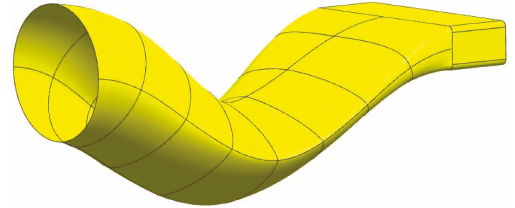
Figure 3: Schematic diagram of a double S-shaped